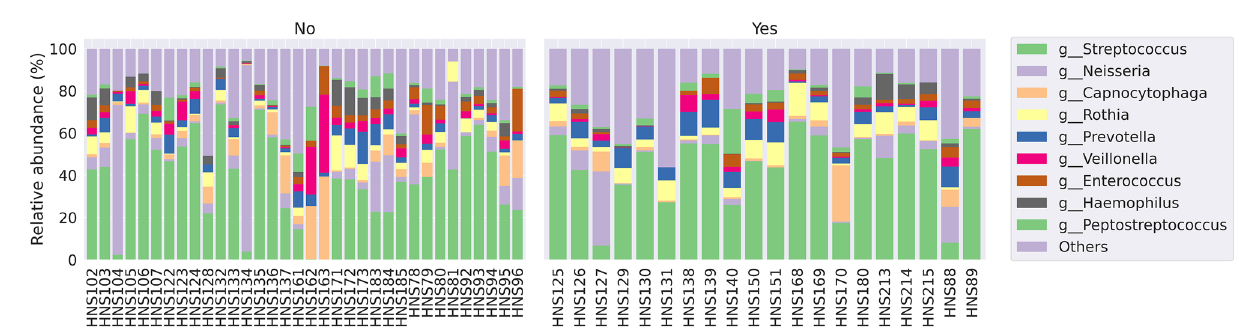
Figure 3. The relative abundance of oral bacterial communities at the genus level between the two